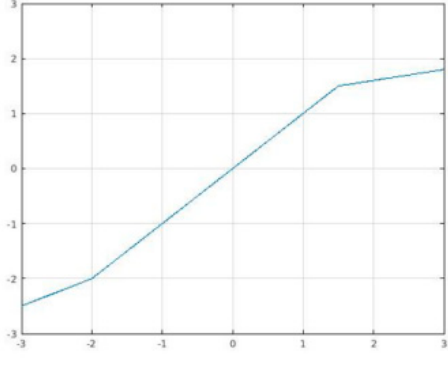
Figure 4. SReLU. Figure 4.